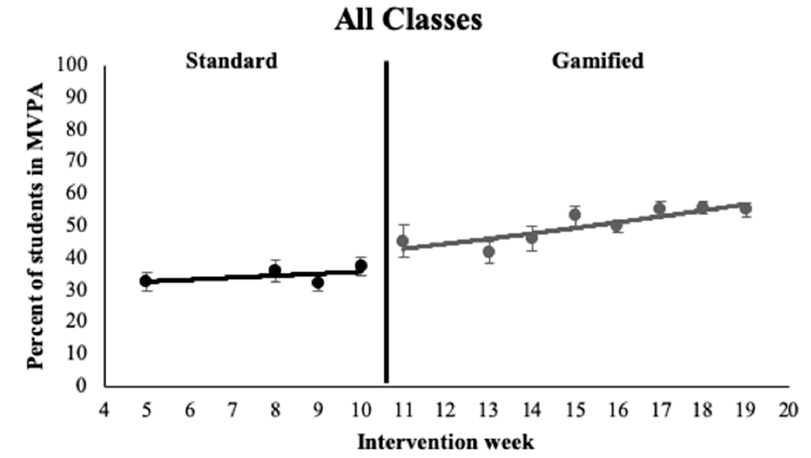
Figure 2. Exponential trendlines for the average student moderate-to-vigorous physical activity (MVPA) participation during an activity break, during the standard and gamified weeks of the intervention, for all classes